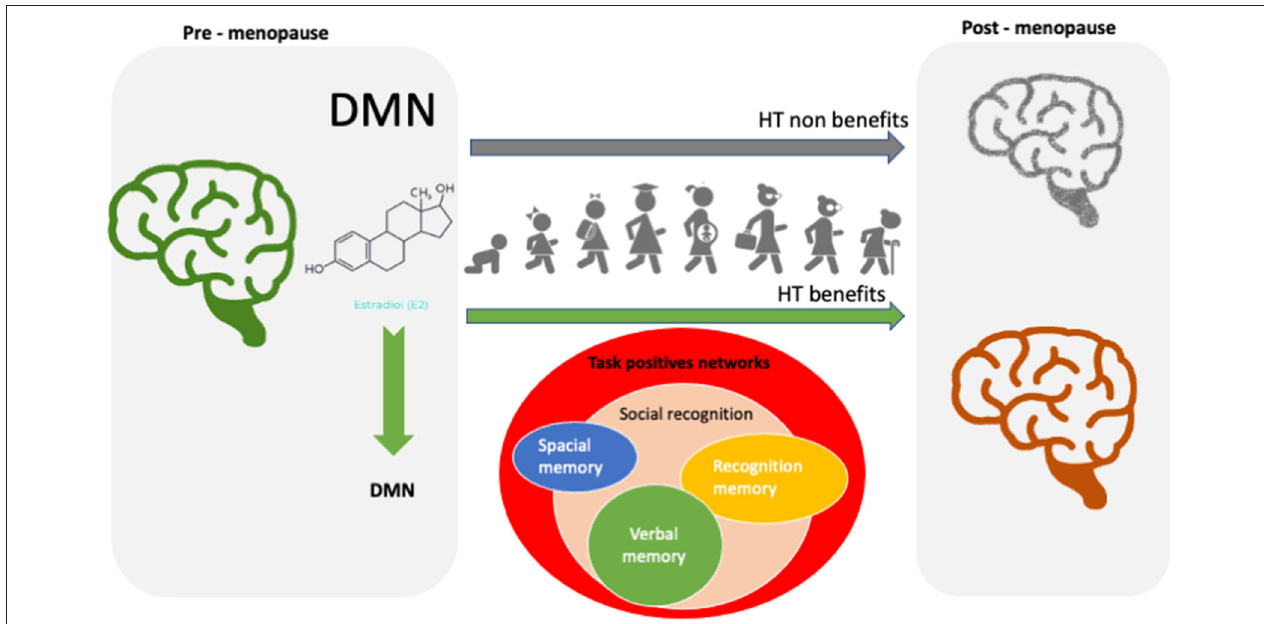
FIGURE 1 | Rapid to long-lasting estrogen